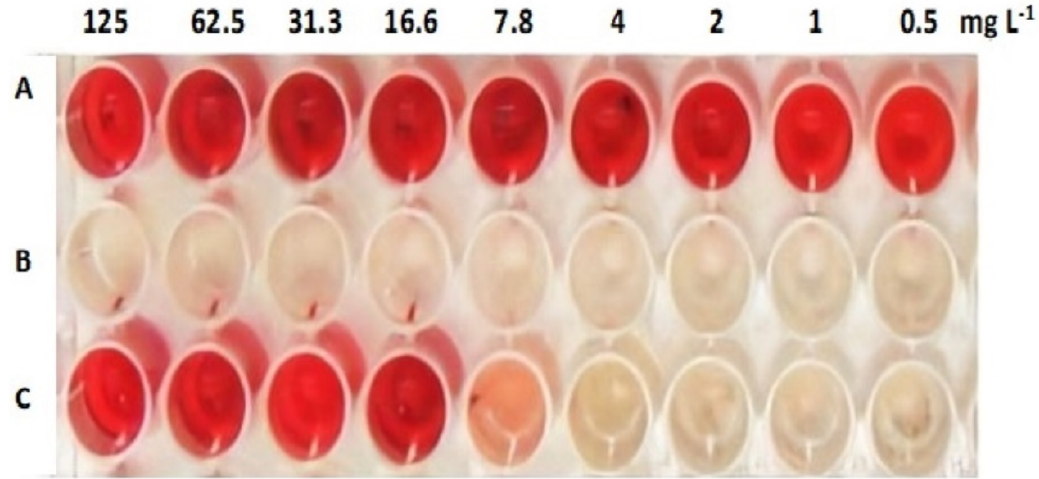
Figure 5. Acid mitigation e ff ect of AKFAs on S. mutans biofilm detected by phenol red indicator. Row A: AKFAs concentrations in the medium (no color change in phenol red indicates no acid production). Row B: Untreated S. mutans cells ( S. mutans grow with acid production indicated by pale yellow color of phenol red). Row C: S. mutans treated with AKFAs showed acidogensis inhibition e ff ect by 125–7.8 mg L − 1 concentrations (red color of phenol red indicator in the first five wells) while AKFAs concentrations less than 7.8 mg L − 1 showed diminished acidogensis inhibition indicated by pale yellow in the last four wells, MNC = 7.8 mg L − 1 ).